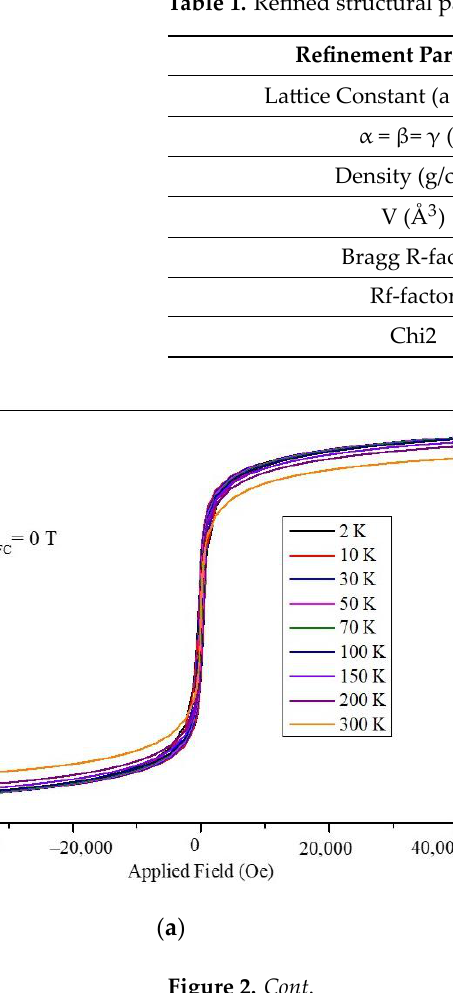
Figure 1. Rietveld refinement of the XRD pattern of the Ti‑doped maghemite nanoparticles. ( Black — experimental data; Red — theoretical diffractogram; Blue — difference between the experi- mental and theoretical data). (* peaks corresponding to the anatase and rutile phases of TiO 2 ). Table 1. Refined structural parameters of Ti doped maghemite nanoparticles.